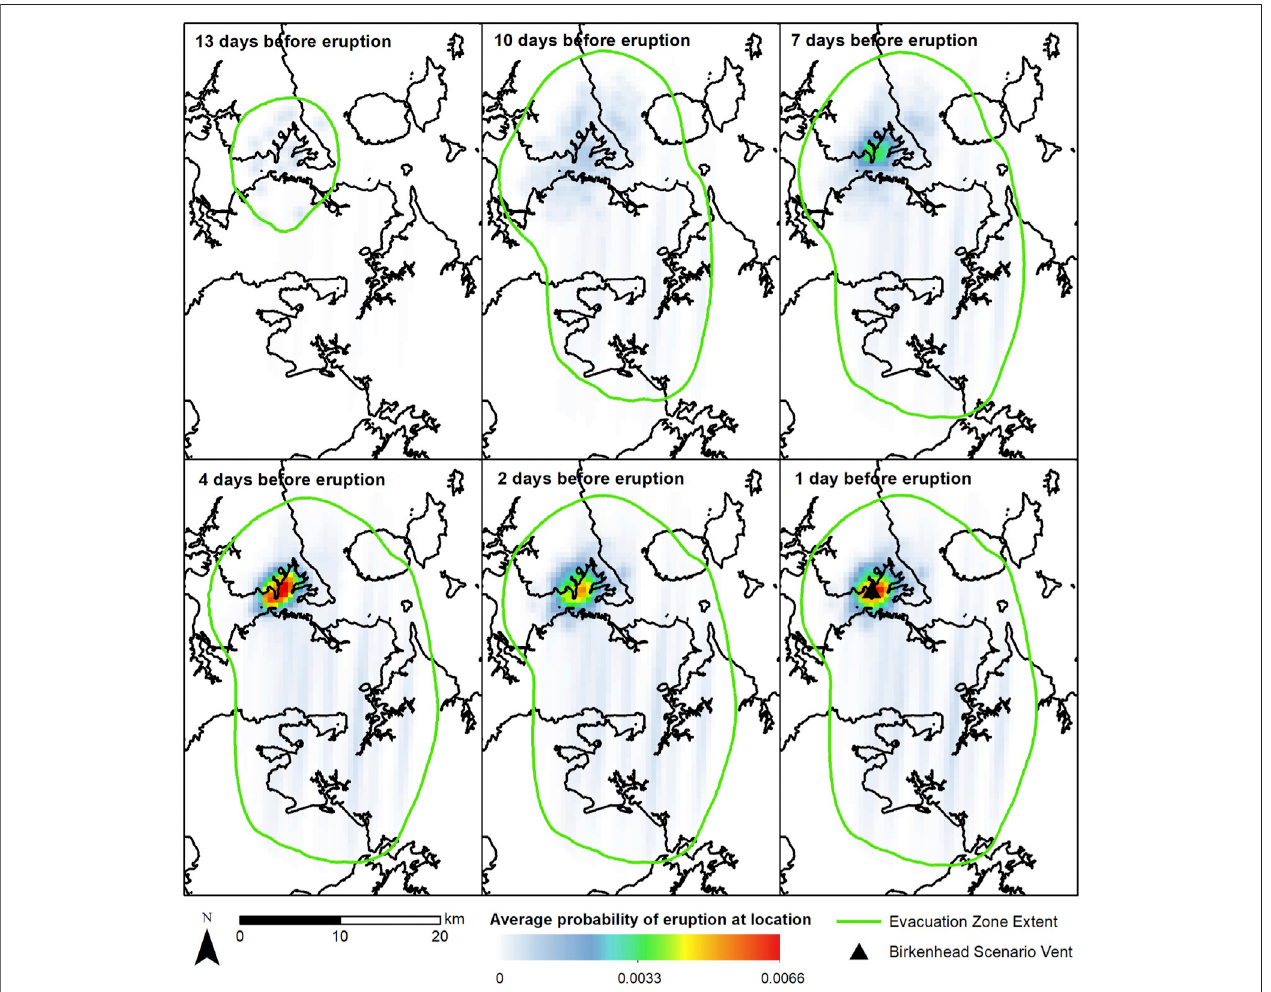
FIGURE8| SpatialdistributionofabsoluteeruptionprobabilitiesfortheBirkenheadscenariofromBETEF_AVFwiththeBebbington2013LSCVpriorventmodelfor selected days leading up to the eruption. The green contour encompasses the evacuation zone extent based on cost-bene fi t analysis.